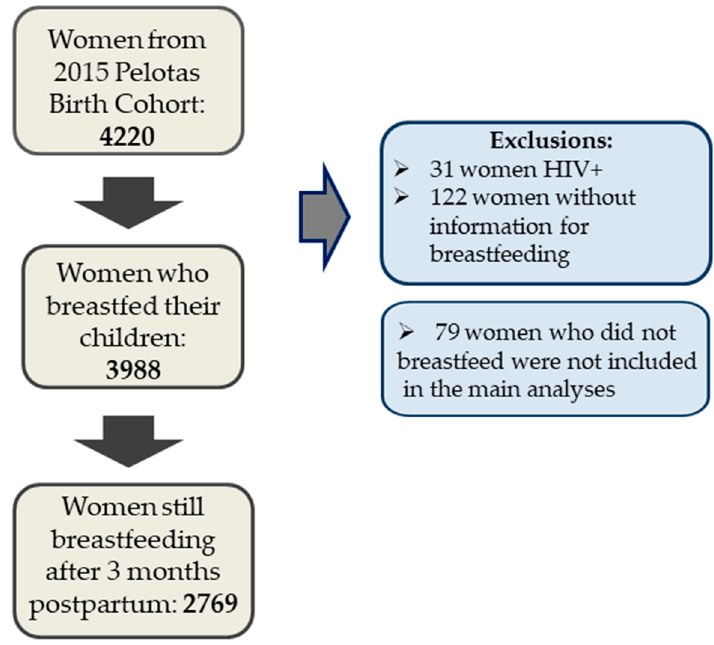
Figure 1. Study participant flowchart. HIV: human immunodeficiency virus. Table 1. Description of the study sample (excluding women who did not breastfeed their children), according to background variables and use of medicines in the first 3 months